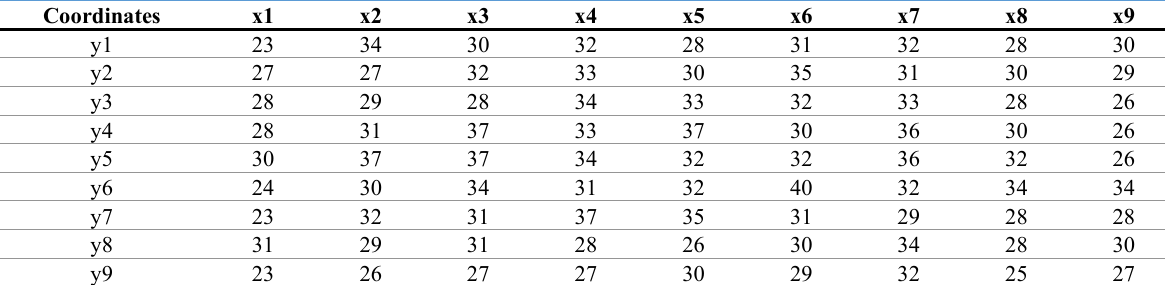
Table 3. Results of the sclerometric index using the regular 2 cm